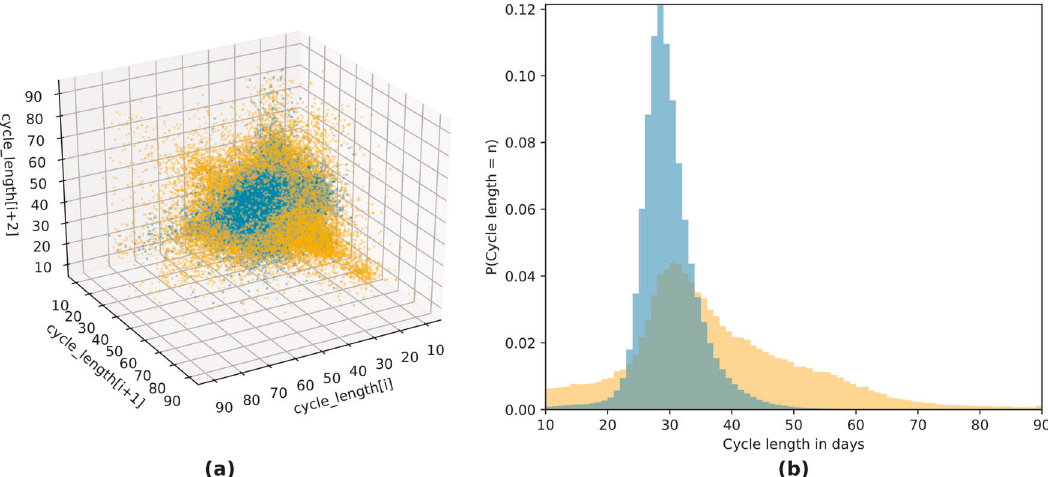
Fig. 3 Time series embedding and probability distribution for cycle length (all users, across groups). Time series embedding ( a ) and probability distributions ( b ) of cycle length for the consistently not highly variable (teal) and consistently highly variable (orange) groups. a The cycle lengths of three consecutive randomly sampled cycles from each user in the cohort are plotted on the x , y , and z axes. Each consistently not highly variable user is represented by a teal point, and each consistently highly variable user by an orange point. It is visually evident that the teal cluster of users occupies a tighter region of the space around the x = y = z line, with the orange cluster fanning outward. b The cycle length probability distributions of the cohort, where we note that the orange group ’ s distribution has a much wider spread and is less peaked than the teal group. Cycle lengths are more heterogeneous or widely distributed for the orange group, con fi rming that the consistently highly variable group represents those with more fl uctuation in cycle length. The cumulative distributions per group differ signi fi cantly (as per a two-sample Kolmogorov – Smirnov